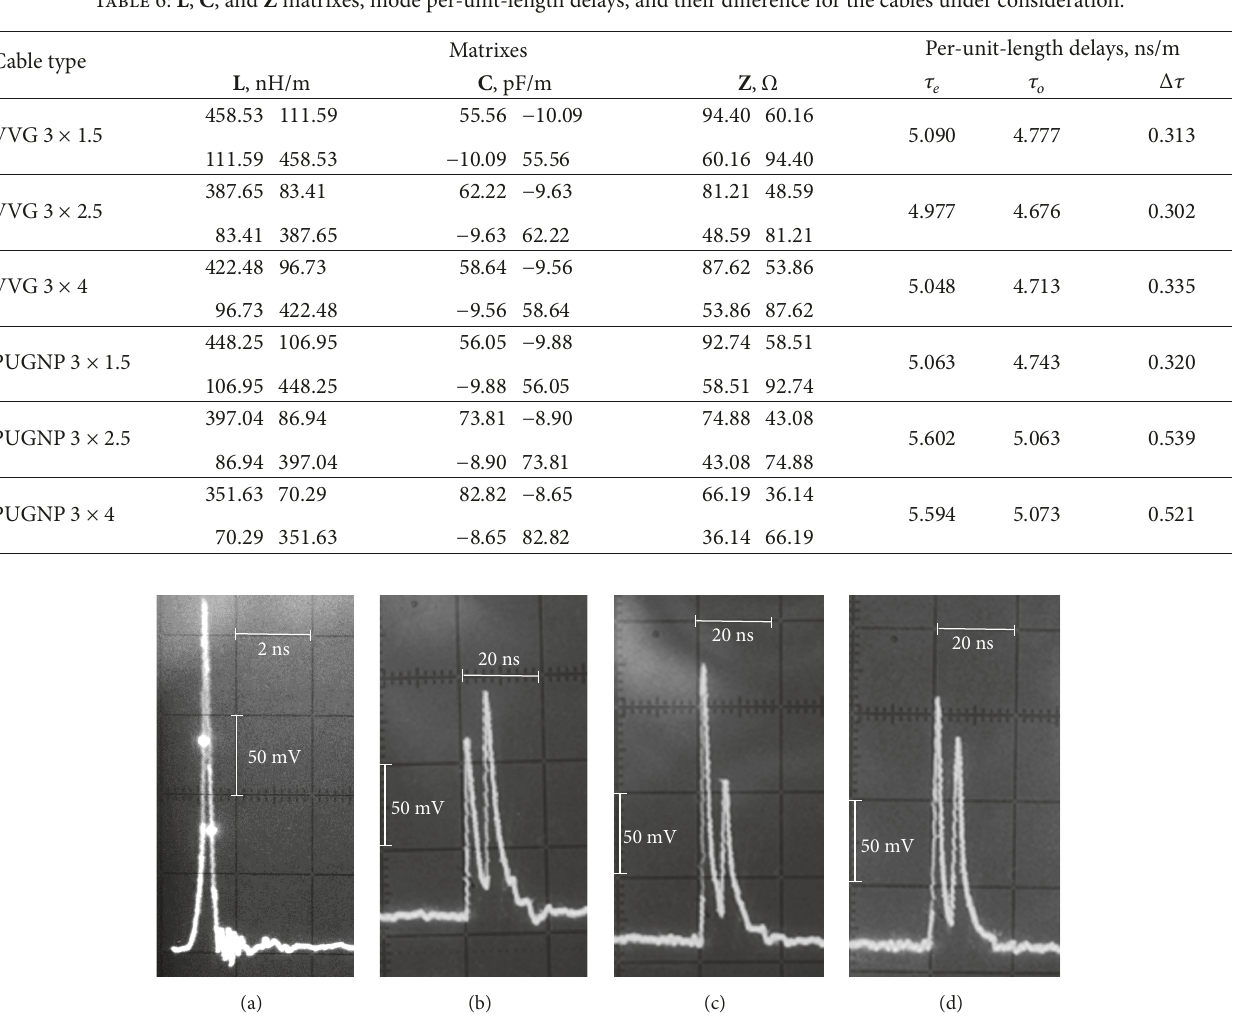
Figure 7: Oscillograms of input signal (a) and signal at the far end of the probing line ( 𝑉4 ) with open circuit (b), short circuit (c), and 100 Ω (d) at both ends of the probed